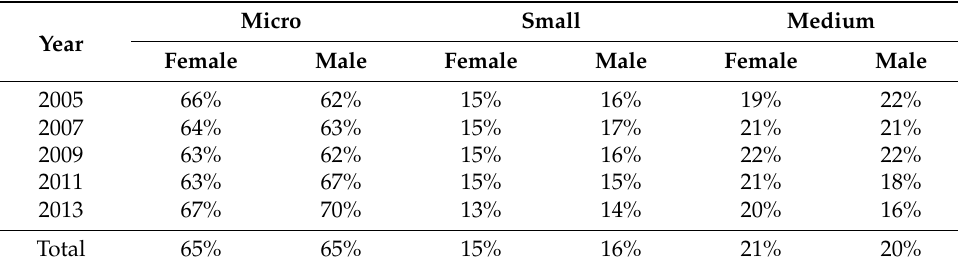
Table 4. Shares of male-led and female-led firms by firm